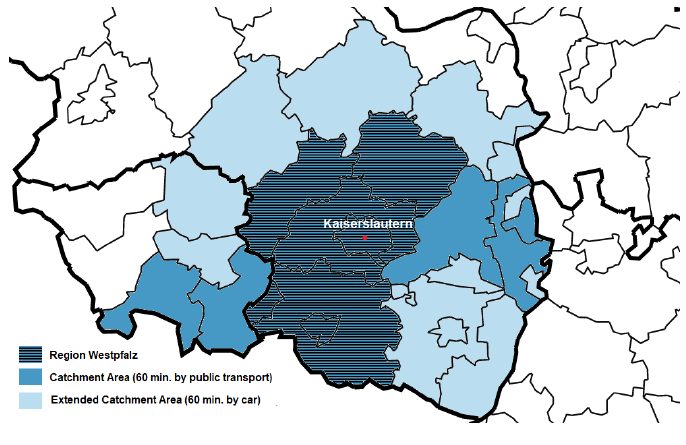
Figure 1: The Region E